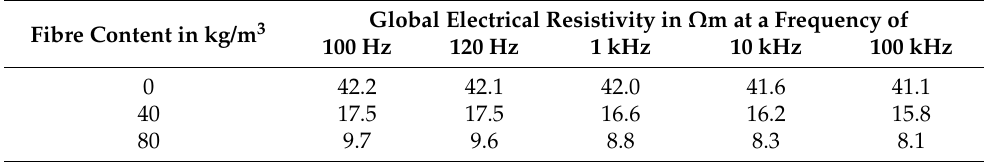
Table A48. Results of the resistivity measurements of the concrete mixture 32-60-300-00 after storage in synthetical pore solution for 14 days for the investigations of possible leaching effects.